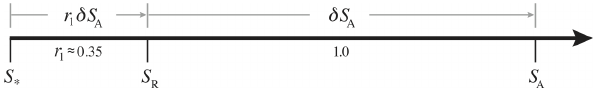
Figure 4. Number line of salinity, illustrating the differences be- tween Preformed Salinity S ∗ , Reference Salinity S R , and Absolute Salinity S A for seawater whose composition differs from that of Standard Seawater which has Reference Composition. If a seawater sample has Reference Composition, then δS A = 0 and S ∗ , S R and S A are all